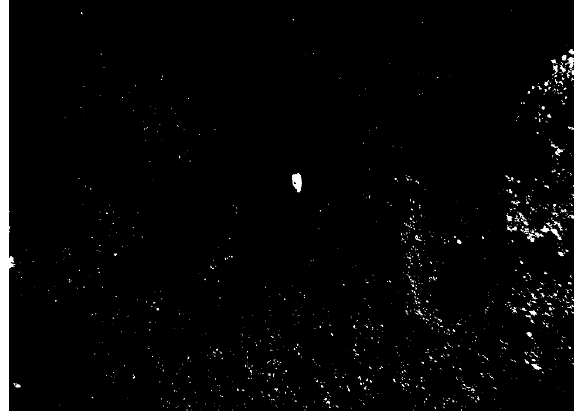
Figure 4. Classification of image in Figure 3 with Random Forest algorithm (case 1).